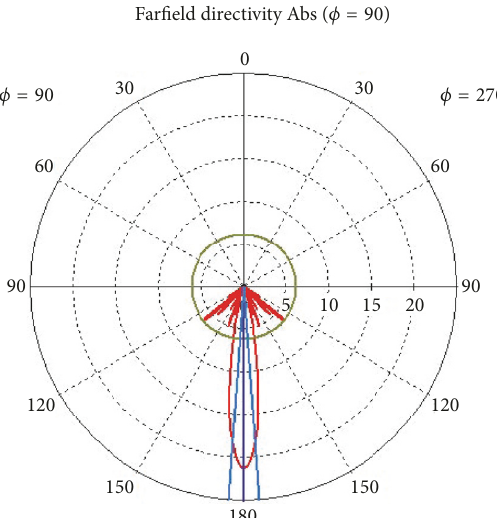
Figure 2: Simulated scanning behaviour of the six-layer lens at 60 GHz and no feed